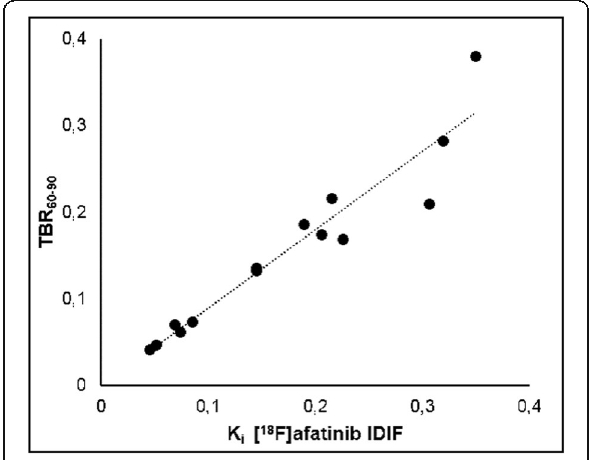
Fig. 5 Correlation plot showing the correlation between K i IDIF of [ 18 F]afatinib and TBR 60 – 90 . R 2 =